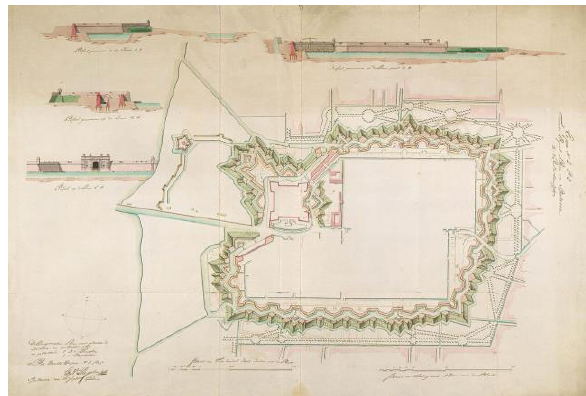
Figure 15. Plan, elevations and sections of the castle of Batavia,